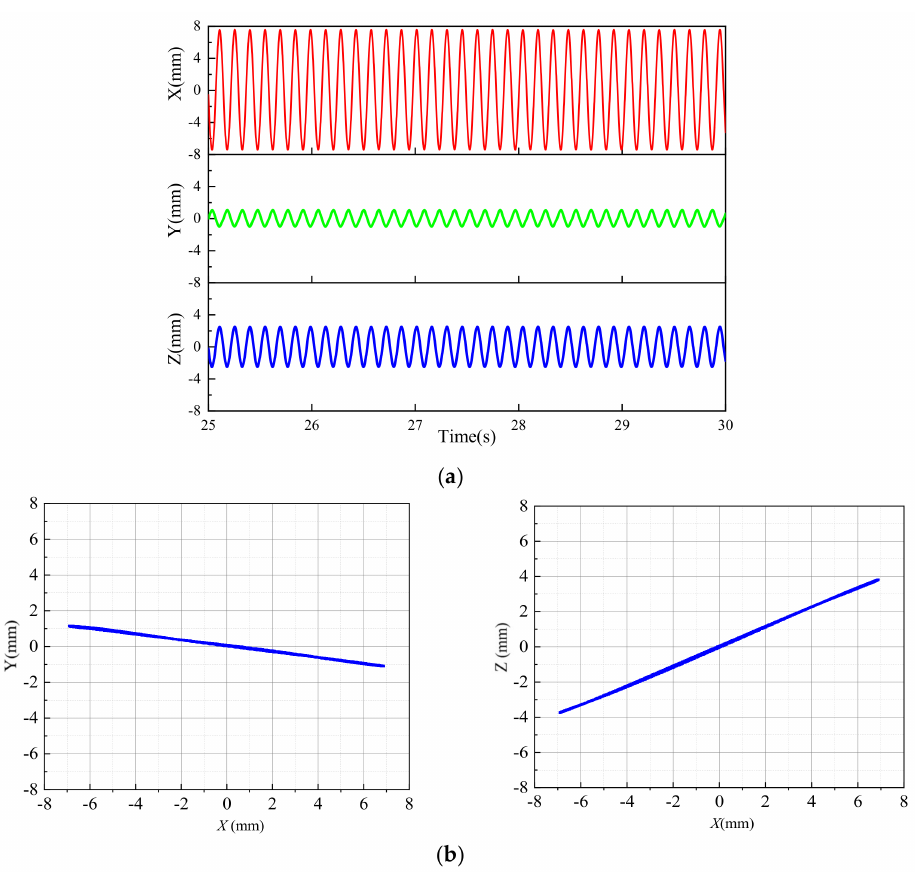
Figure 5. X–Y and X–Z motion characteristics of bed surface in the stable stage. ( a ) Time-domain response curve of displacement at steady stage. ( b ) Lissajous-Figure of displacements at stable